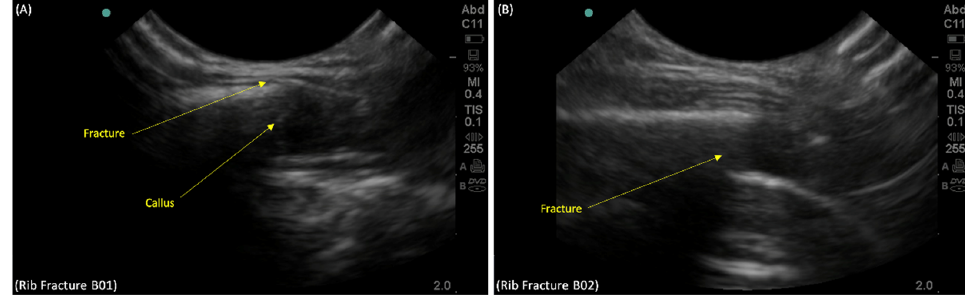
Figure 2. Point-of-care-ultrasound of the right fourth rib on longitudinal view showing: ( A ) a disruption in the callus of the old fracture on the right fourth anterior rib (B01), suggesting a refracture of the right fourth anterior rib and ( B ) cortical disruption (B02) of the right posterior fourth rib on longitudinal view using POCUS, suggesting a new fracture as reported in the chest radiographs.